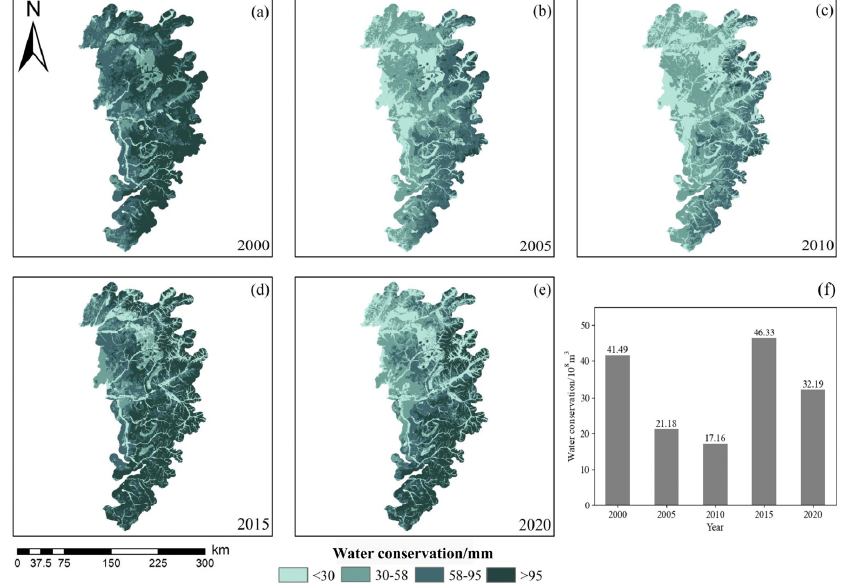
Figure 3. Temporal and spatial distribution of water conservation in Hulunbuir forest–steppe eco ‐ tone from 2000 to 2020. ( a – e ) represent the spatial distribution of water conservation in the Hulun